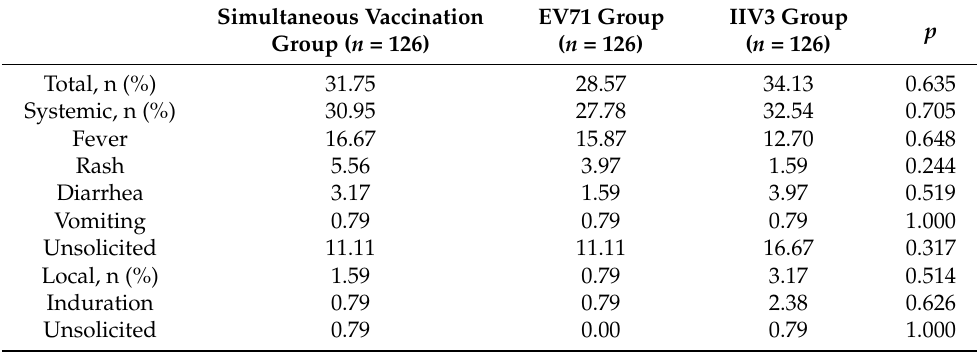
Table 1. Reported adverse events following any vaccination within 28 days.